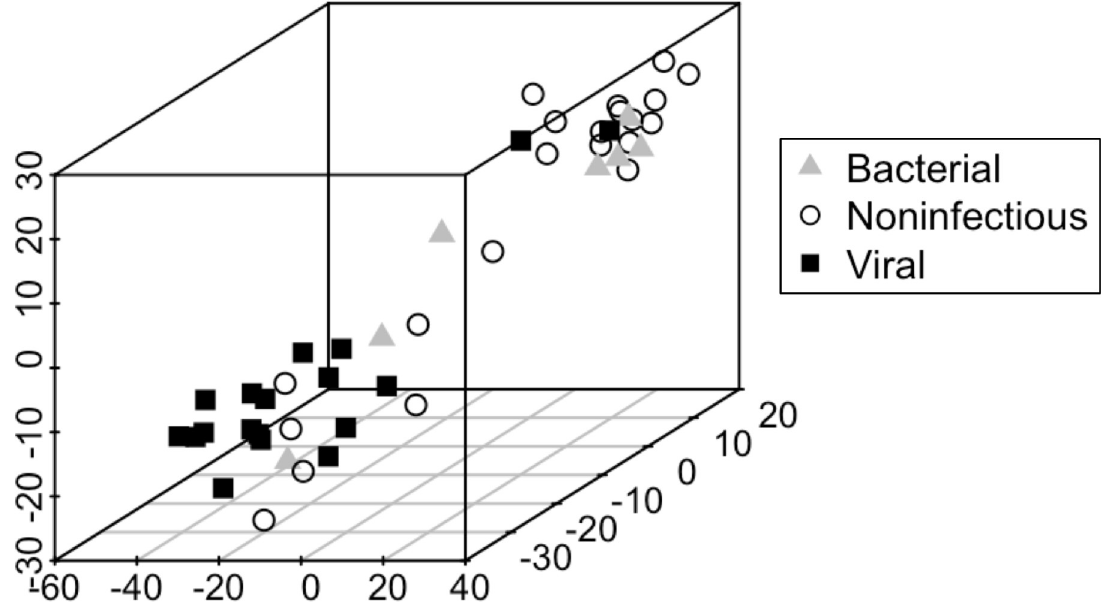
Fig 4. Dimensionality reduction to visualize differences between asthma exacerbation subgroups with respect to all gene targets. Unsupervised analysis using t-distributed stochastic neighbor embedding (TSNE) was utilized to depict the visual relationships between all 46 subjects with asthma exacerbations. Each subject is labeled by their respective bacterial, viral, or noninfectious status, based on clinical adjudication. Notably, in TSNE, the axes are not meant to be interpretable; this plot represents a 3D projection of higher dimensional